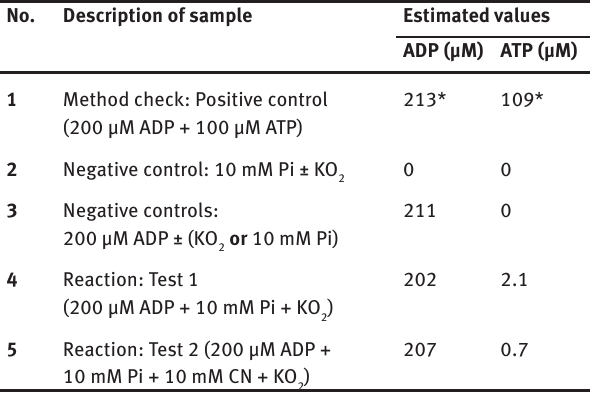
Table 7: Estimation of ADP and ATP in reaction milieu by HPLC